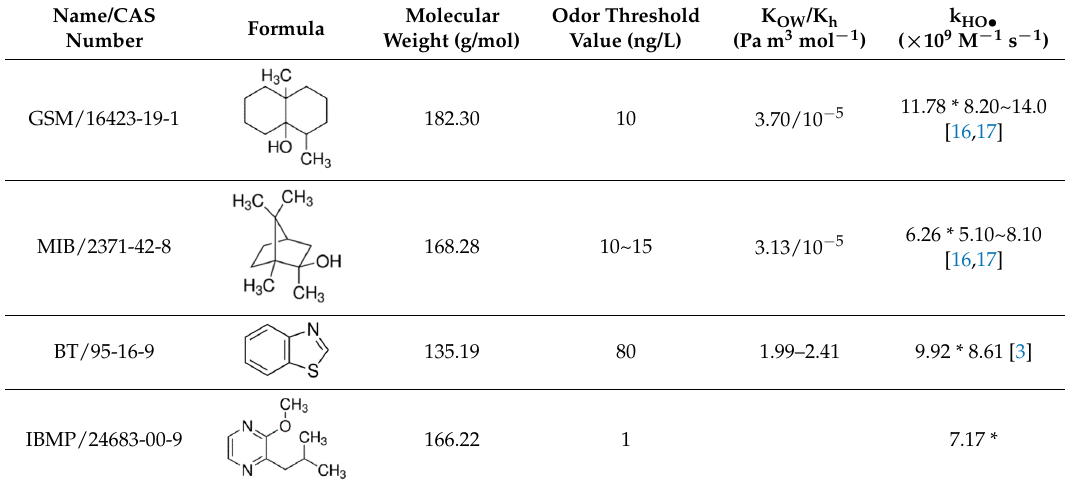
Table 1. Properties of selected taste and odor (T&O) compounds in this study.